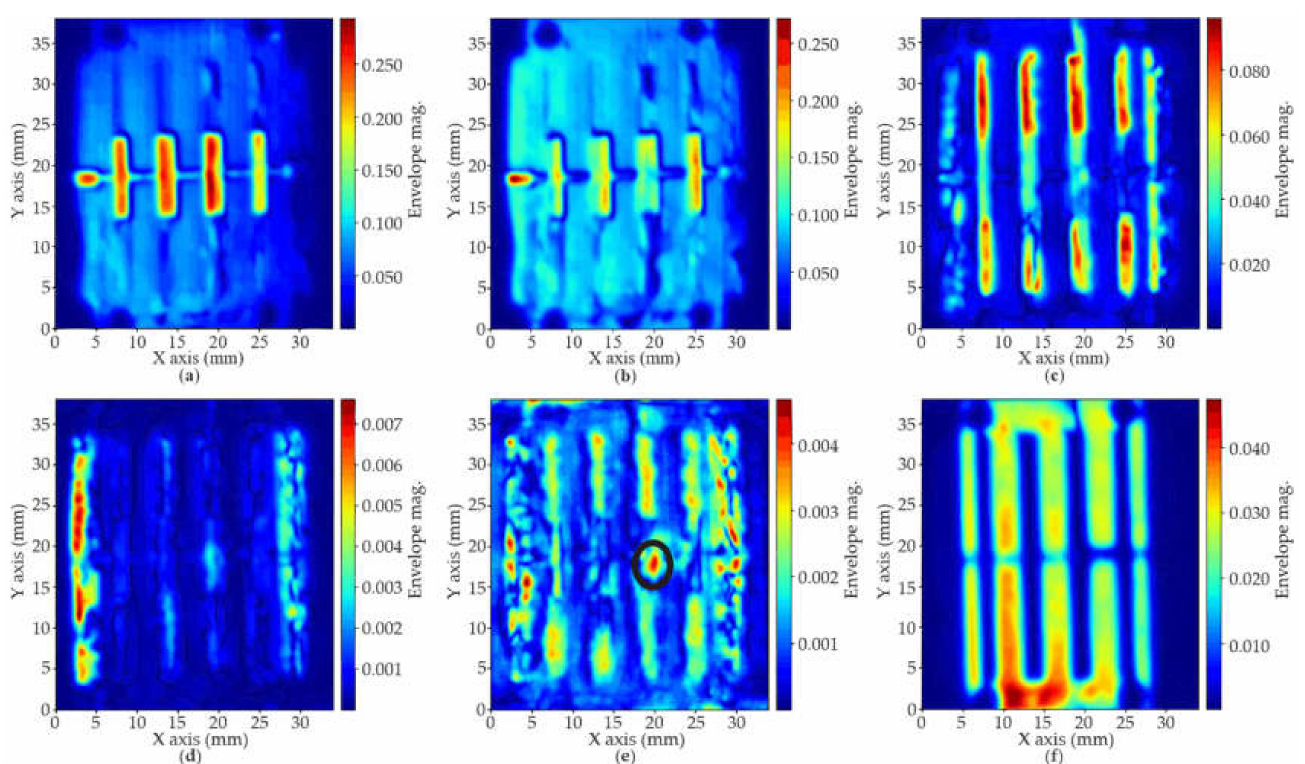
Figure 17. Examples of 2D profiles of the inner composition at different depths. Inner scans provide useful information regarding the homogeneity of the fabricated structure and reveal the presence of voids, bubbles and other